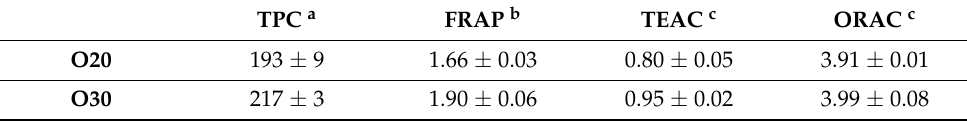
Table 2. Total phenolic content and antioxidant capacity of both olive byproduct